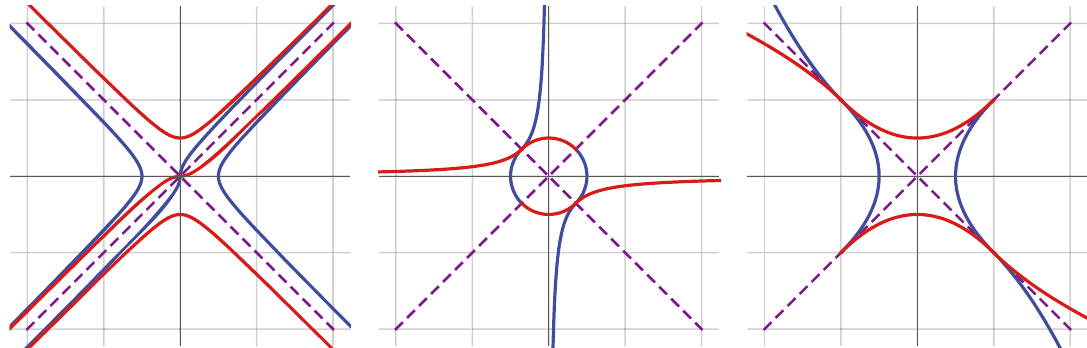
Figure 12: Lorentzian sinusoidal spirals in (cid:2) 2 with = n 1 ( left ) , = n −2 ( center ) and = / n −1 2 ( right )